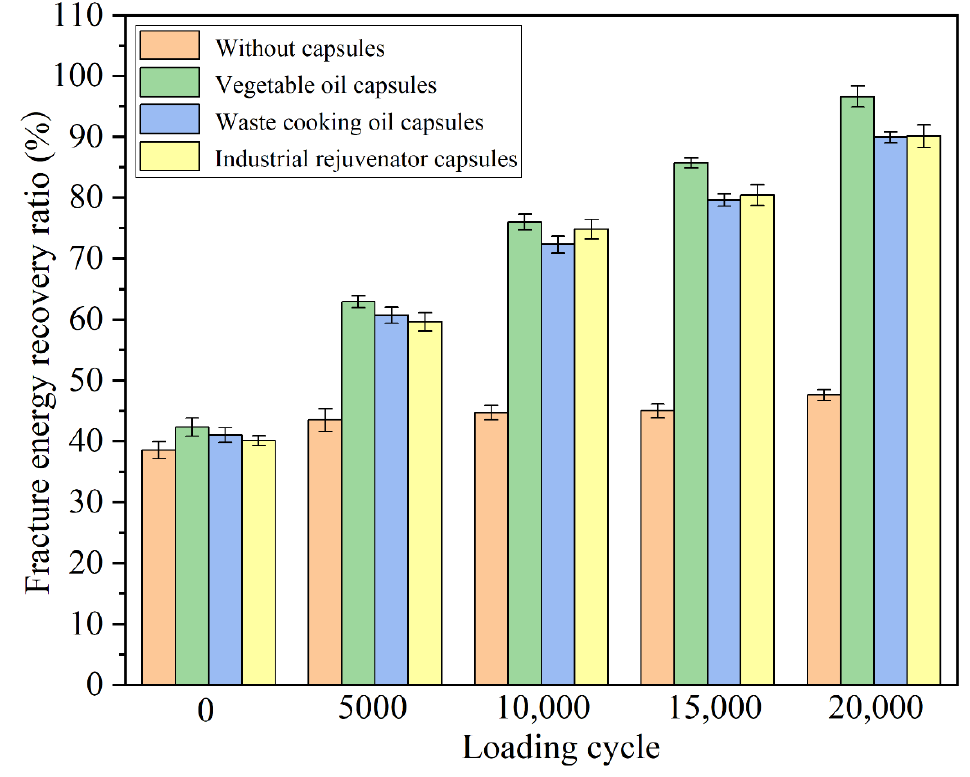
Figure 9. Fracture energy recovery ratios of the fractured specimens containing different capsules after different cycles of compression loading at 1.4 MPa.